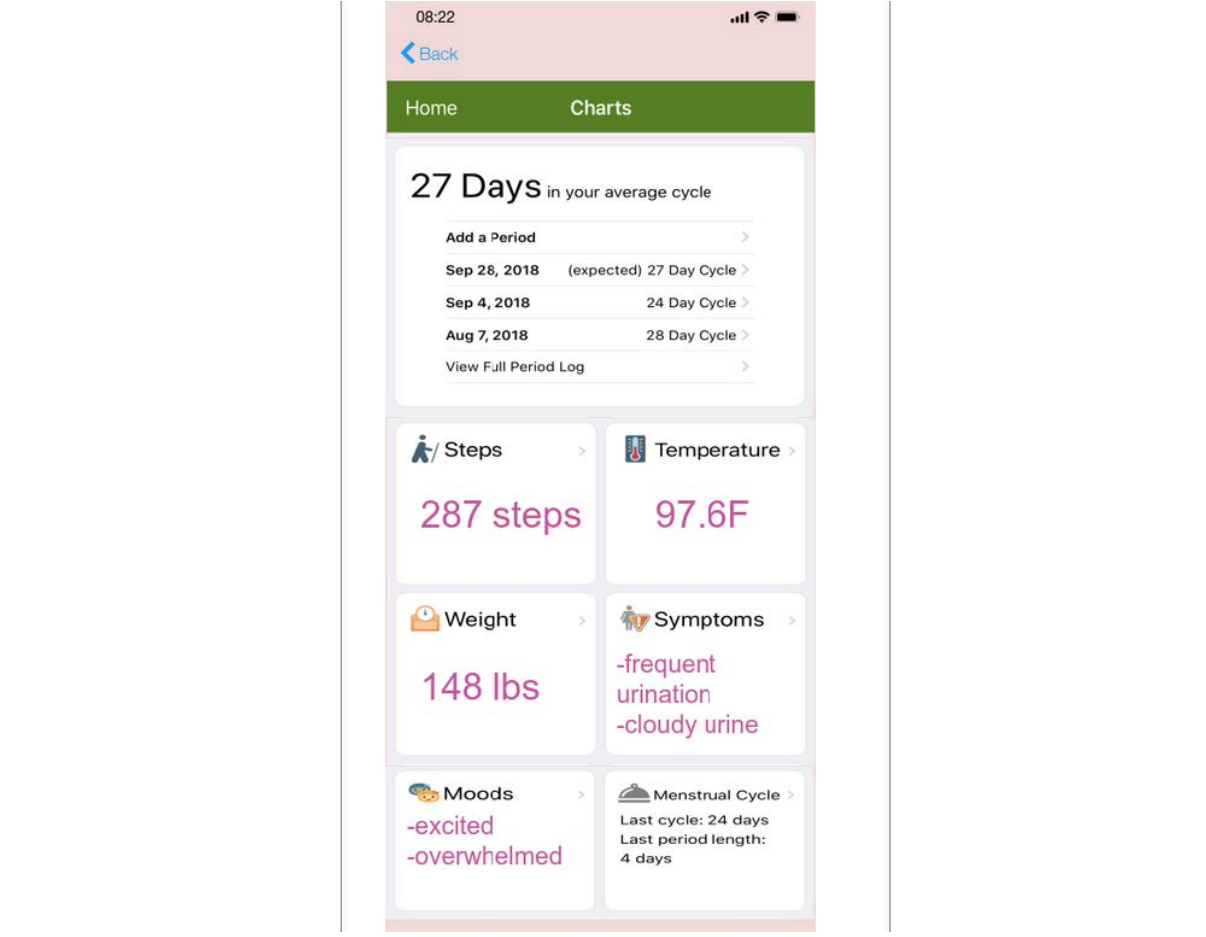
Figure 1. Comprehensive health features included in the sample mobile app